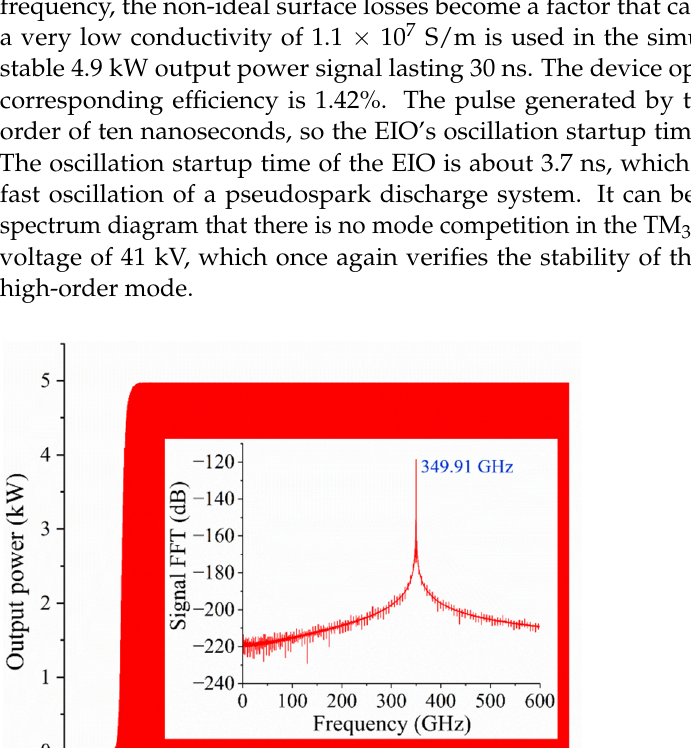
Figure 6. Normalized G e as a function of beam voltage for the TM 31 -3 π , TM 31 -(3 π − 1), and TM 01 -(2 π + 1) modes in the multiple sheet beam EIO.